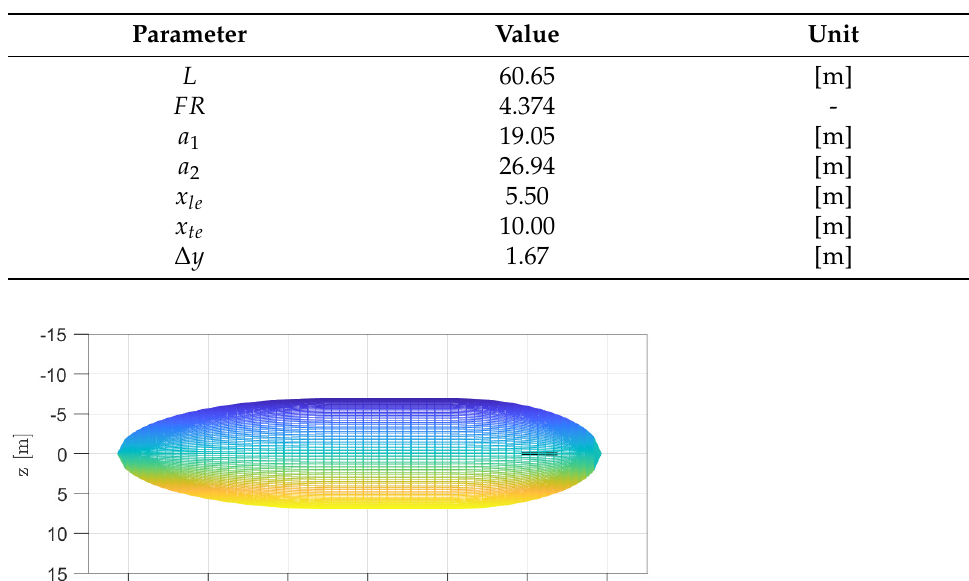
Table 4. HiSentinel80 assumed design parameters.